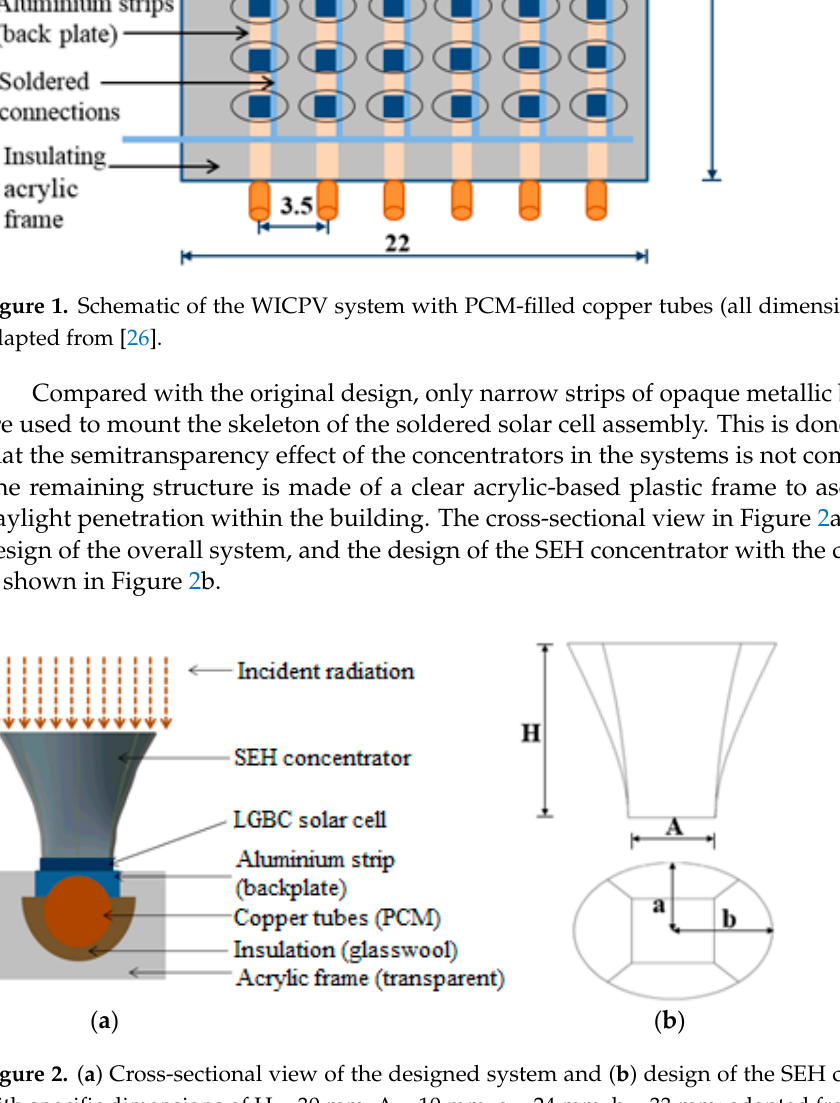
Figure 1. Schematic of the WICPV system with PCM-filled copper tubes (all dimensions in mm); adapted from [26].